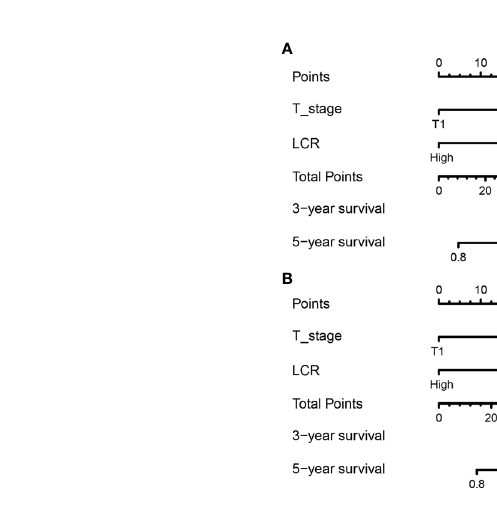
FIGURE 2 | Establishment of nomograms for the prediction of 3- and 5- years OS (A) and DFS (B) in patients. OS, overall survival; DFS, disease-free survival.